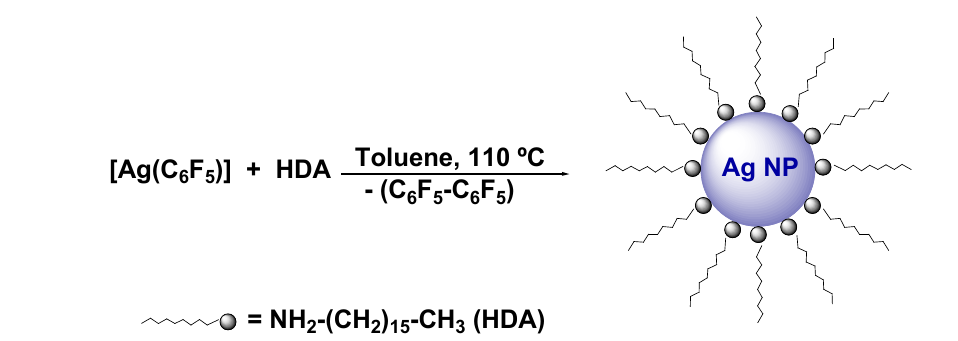
Figure 11. Organometallic method for the synthesis of silver